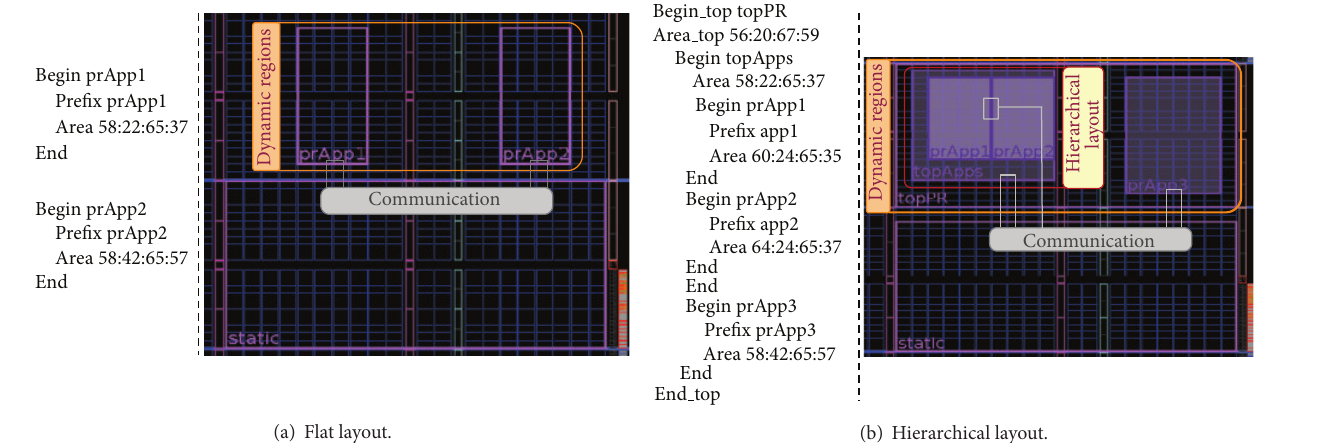
Figure 5: Dynamic reconfigurable areas